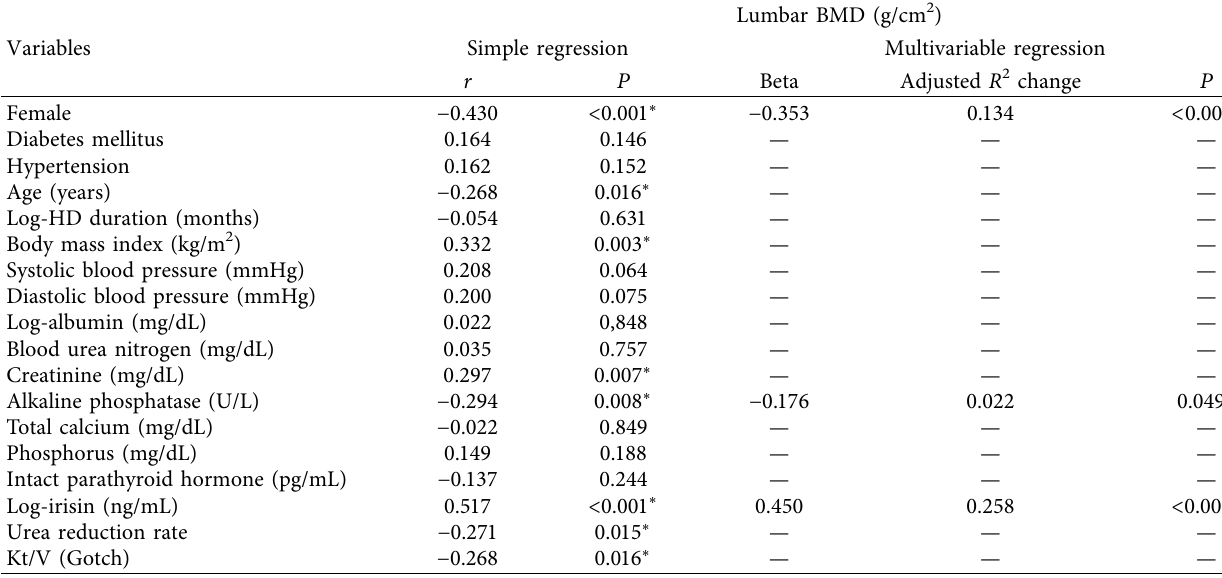
Table 2: Correlation of lumbar BMD levels and clinical variables by simple regression or multivariable linear regression analyses among the 80 hemodialysis